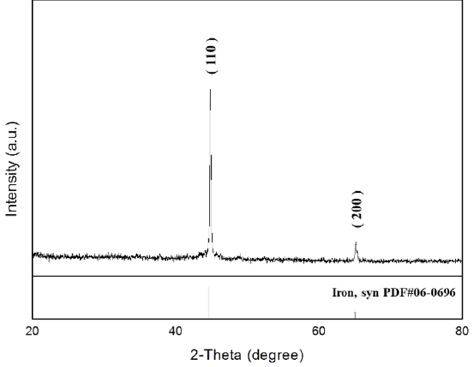
Figure 1. X-ray diffractometry (XRD) of synthesized mesoporous iron particles.